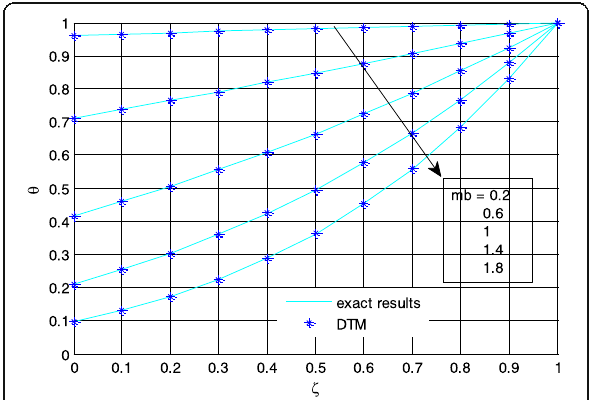
Fig. 6 Temperature evolution for a cylindrical fin